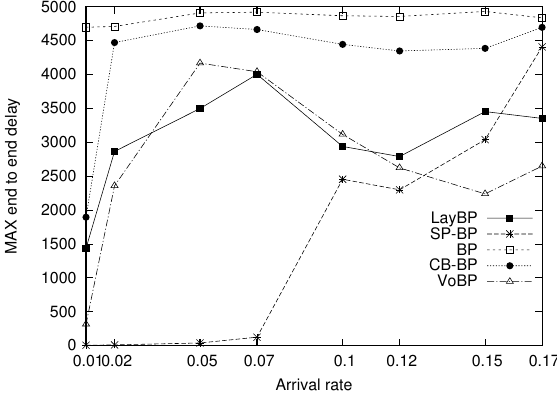
Figure 9. Maximum end to end delay for the network topology with 30